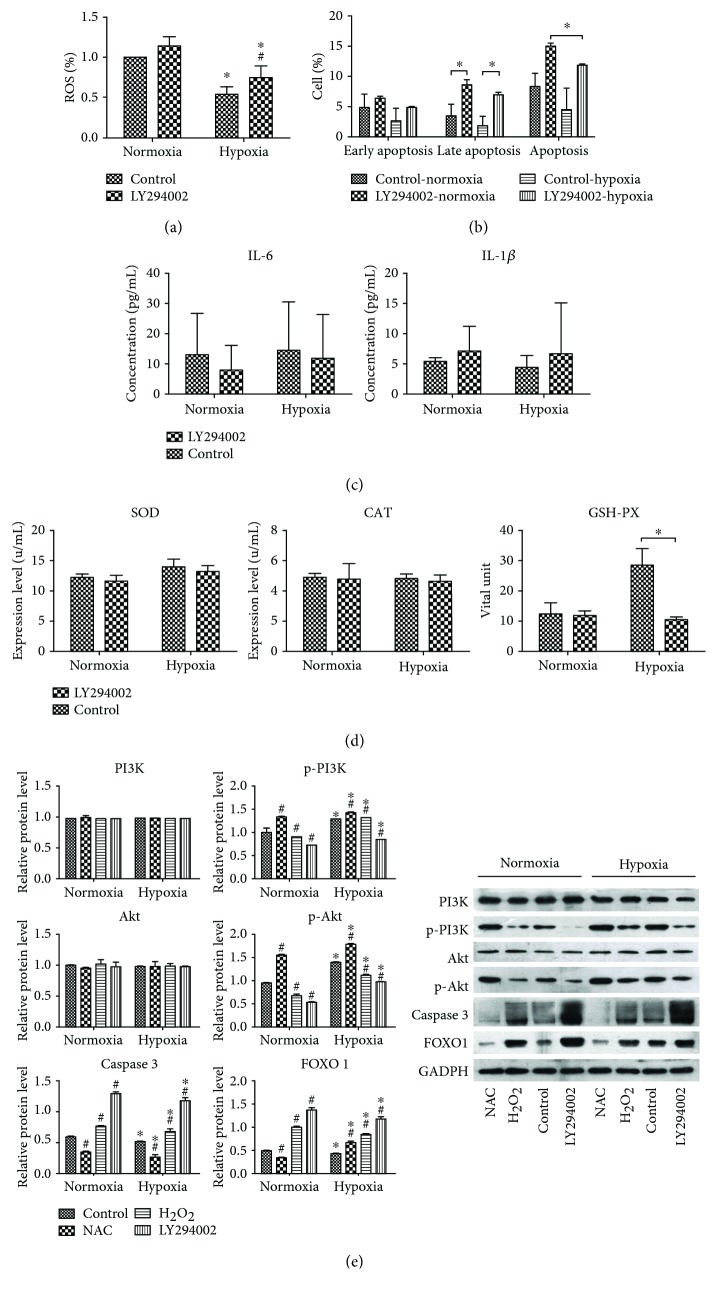
Inhibiting the PI3K/Akt pathway changed the redox status of hDPCs after 2 d of culture under normoxia and hypoxia: (a) hDPCs were stained with 10 μM of DCFDA and analyzed by flow cytometry; (b) flow cytometry and quantitative analysis of cell apoptosis ratio in different treatment groups; (c) levels of inflammatory cytokines secreted by each group, as determined by ELISA; (d) activity of the antioxidant enzymes SOD, CAT, and GSH-PX in hDPCs from each group; (e) western blot assay and quantitative expression of PI3K, p-PI3K, Akt, p-Akt, Caspase 3, and FOXO1 in different groups. Statistical significance is expressed as ∗
p < 0.05 versus normoxia; #
p < 0.05 versus control.